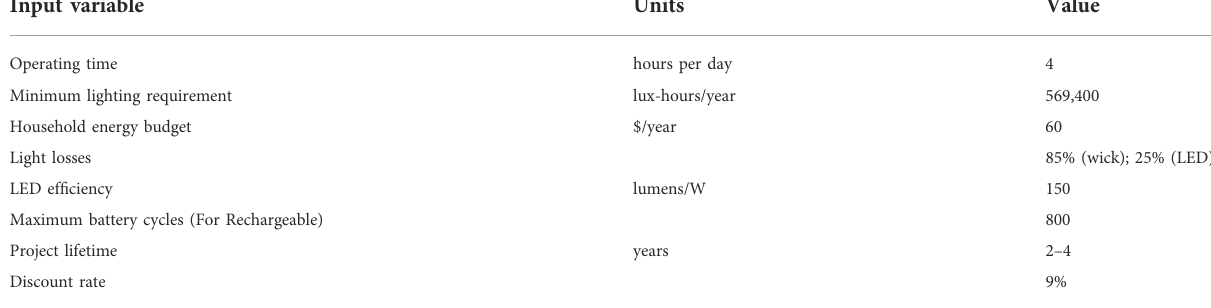
TABLE 1 Input assumptions for the LCOL